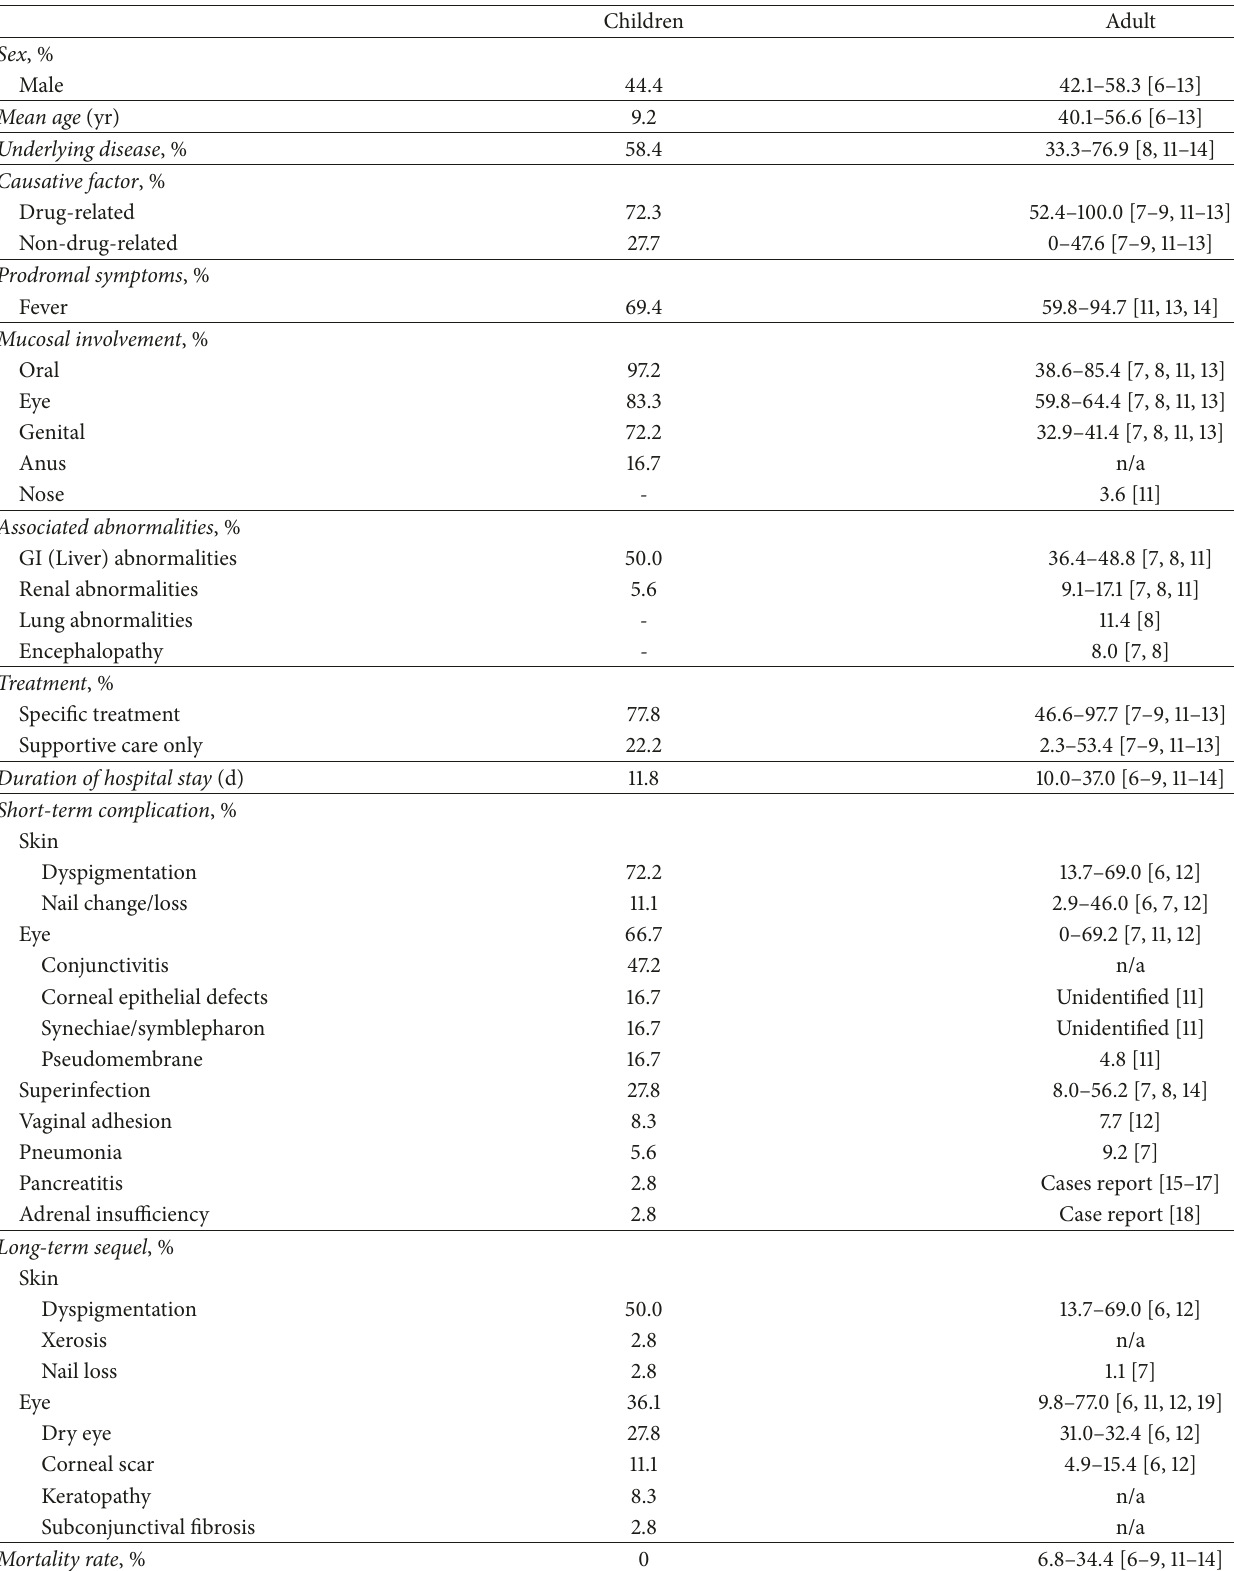
Table 6: Comparison of clinical features and treatment outcomes between children and adults with Stevens-Johnson syndrome and toxic epidermal